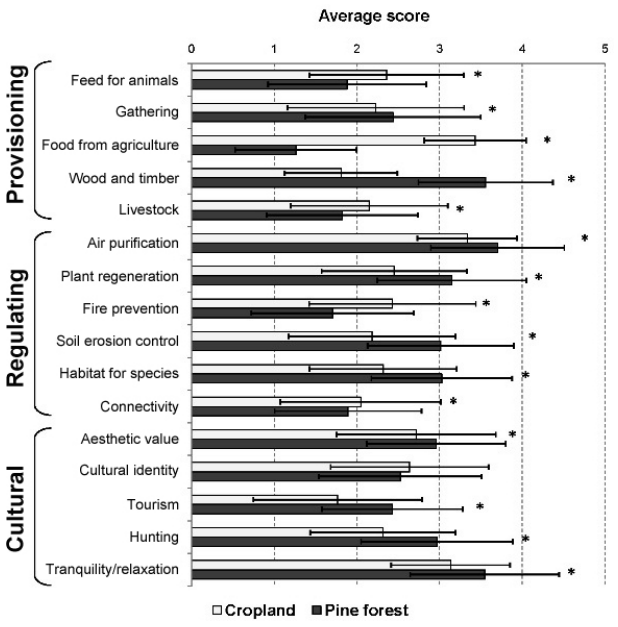
Fig. 2 . Average scores (and standard deviation) of the perception about the capability of croplands and forests to deliver ecosystem services. Asterisks show significant differences between cropland and forest ecosystems using the Wilcoxon test (p <